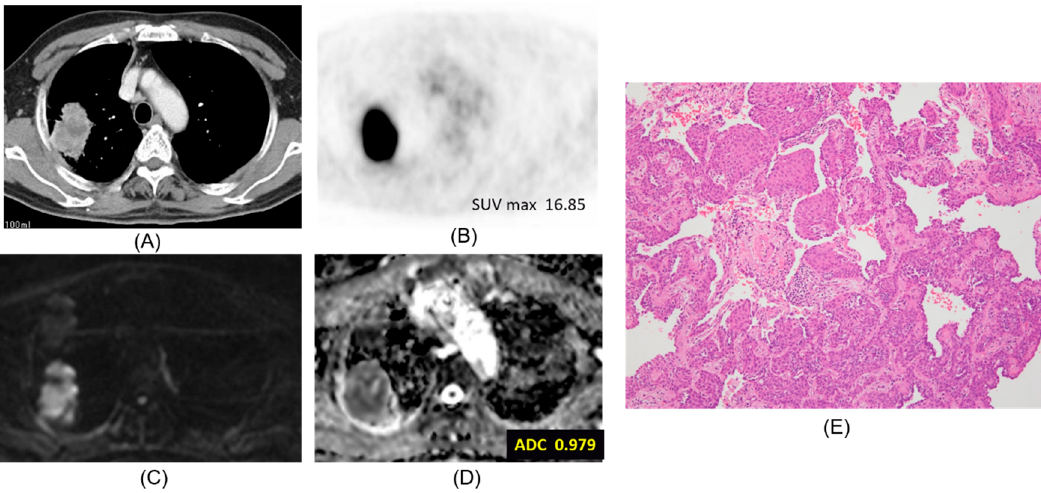
Figure 4. Squamous cell carcinoma. The ADC of the carcinoma was 0.979 × 10 − 3 mm 2 /s. ( A ) CT, ( B ) PET-CT, ( C ) DWI, ( D ) ADC map, ( E ) Pathology (Hematoxylin and Eosin Staining) ×100.